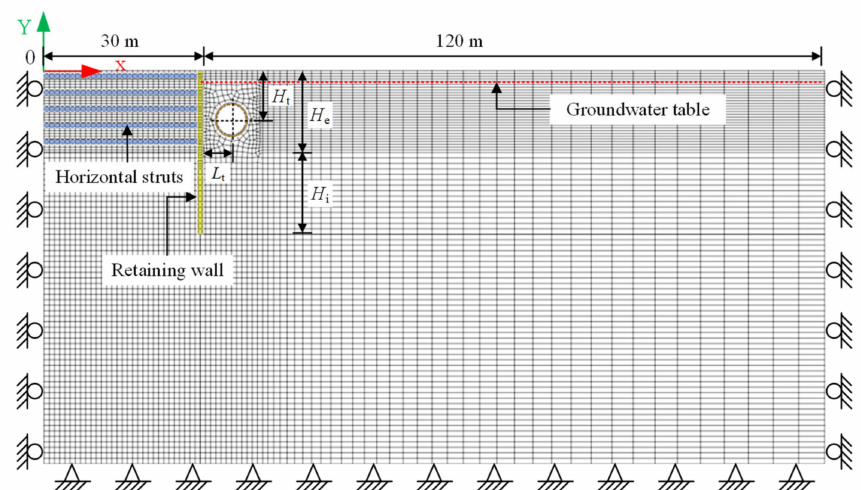
Figure 1. FEM numerical model used to study the effect of adjacent excavation on existing tunnel. In the model, the soil is simulated using a plane strain element, the retaining wall, horizontal struts and existing tunnel are simulated using beam elements, and the contacts of the wall–soil and tunnel–soil are simulated using the interface element. For displacement boundary conditions, the left and right boundaries are limited to the horizontal displace- ment, the bottom boundary is limited to the horizontal and vertical displacements, and the top boundary is kept free. For load boundary conditions, only the self-weight stress